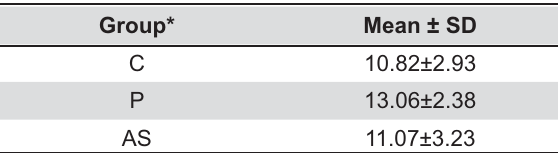
Table 1- Push-out bond strength (MPa) means ± standard